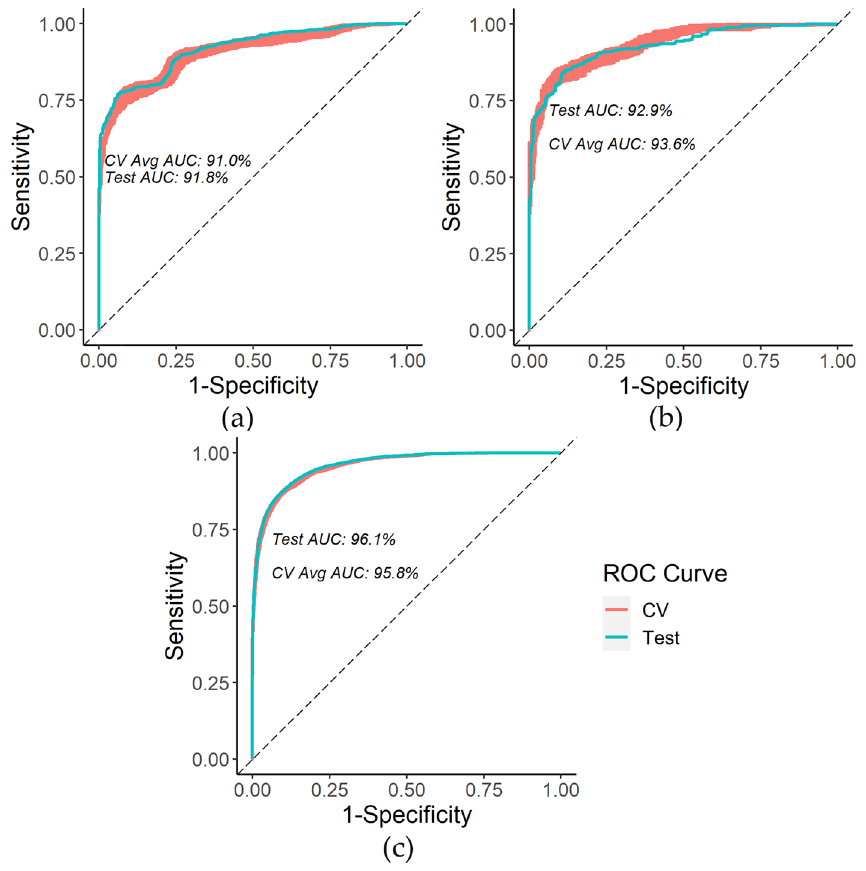
Figure 4. ( a ) Pediatric 30-year survival time-dependent ROC curve example; ( b ) Adolescent 30-year survival time-dependent ROC curve example; ( c ) Young adult 30-year survival time-dependent ROC curve